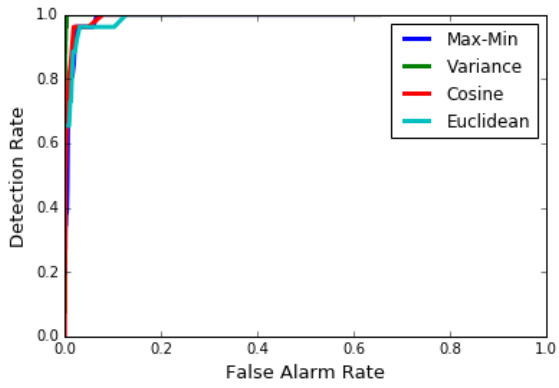
Figure 19. ROC curve of different detector on PUE attack.